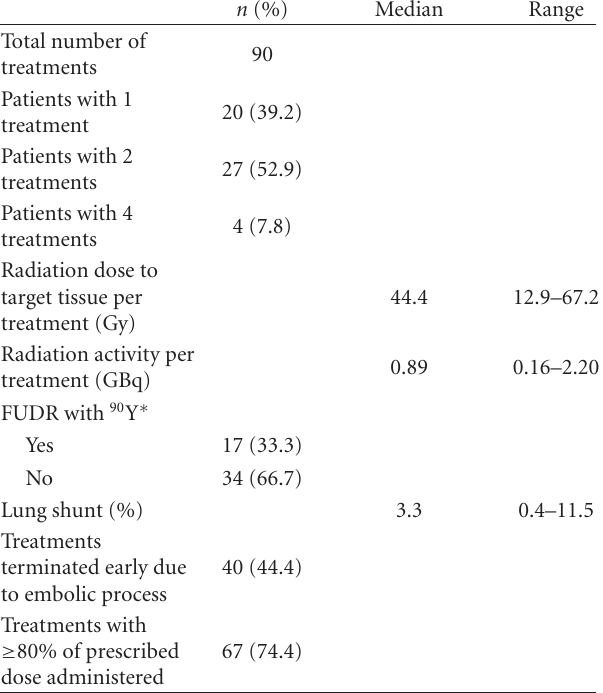
Table 2: Treatment characteristics: Floxuridine (FUDR) was given with 90 Y in some of our earlier patients. FUDR (5mg/kg) was given just prior to administration of the 90 Y microspheres.